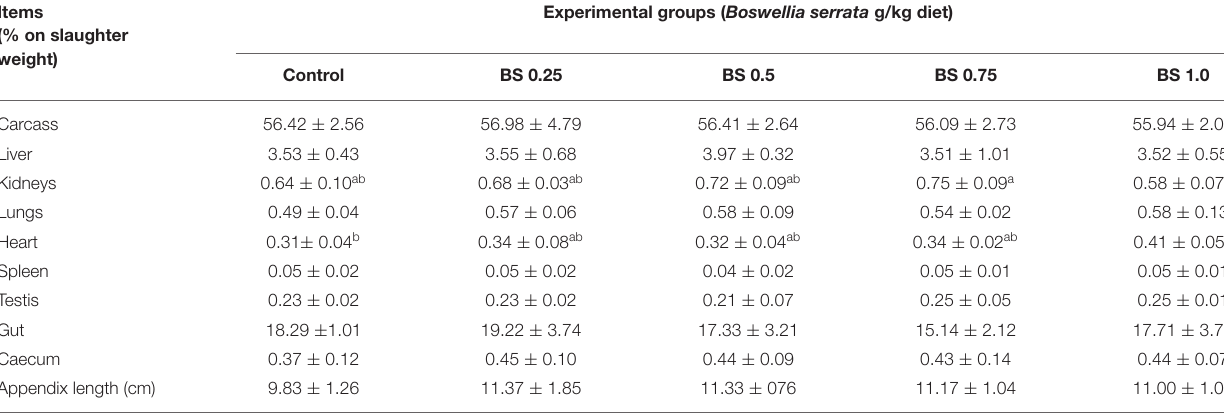
TABLE 3 | Effect of Boswellia serrata on carcass traits of NZW rabbits at 12 weeks of age. Items (% on slaughter